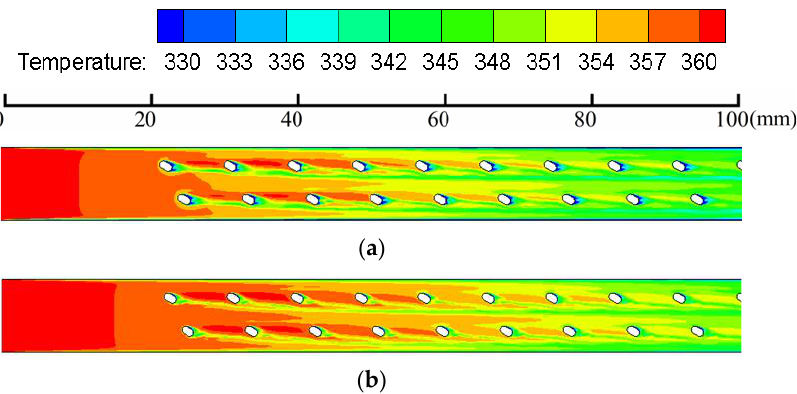
Figure 14. Mean static temperature ( a ) and its partial gradient in the stream-wise component ( b ) for different Reynolds numbers.